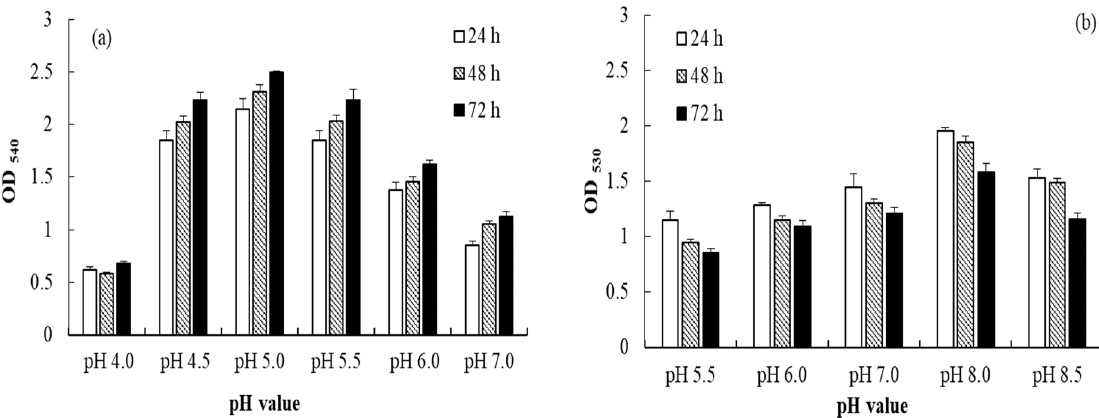
Figure 1. Effects of pH on the AuNPs synthesized by ( a ) B. lactis and ( b ) E. coli after 24, 48, and 72 h of incubation.